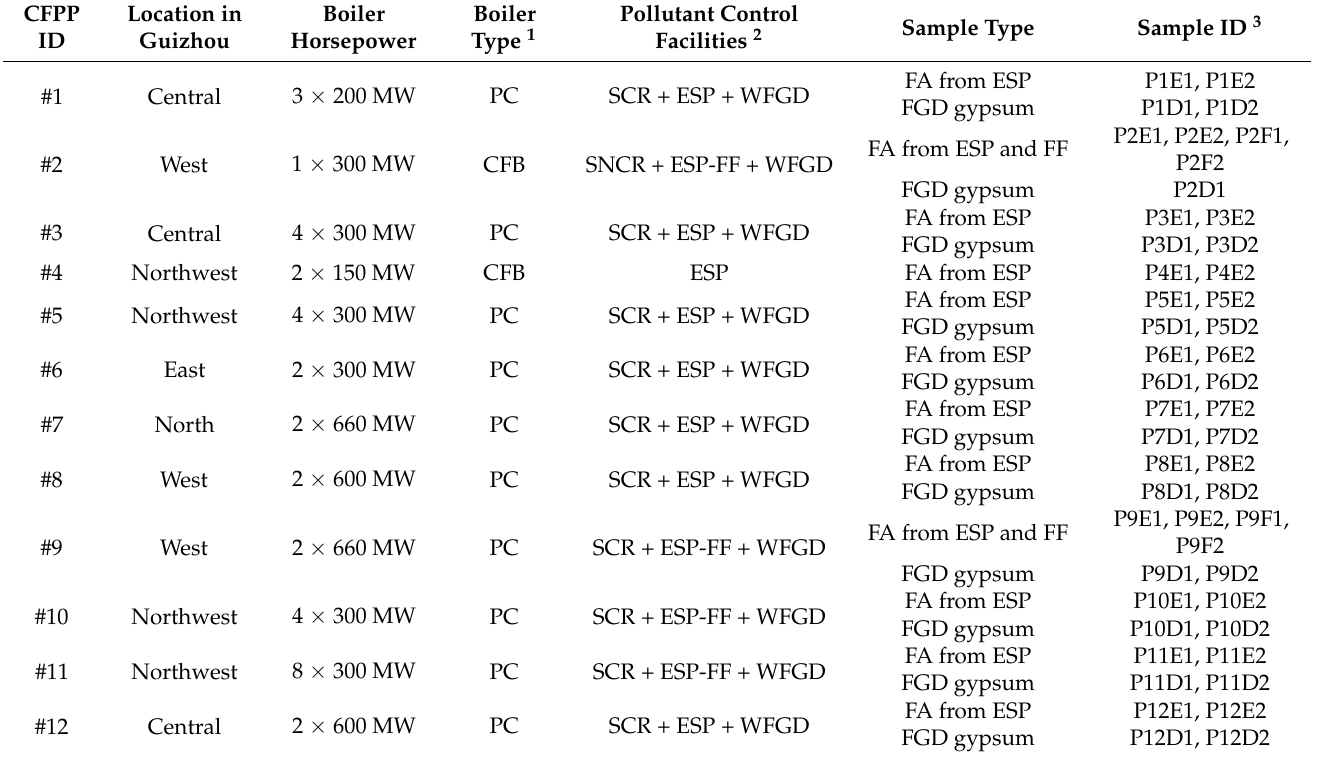
Table 1. Detailed information about the solid samples collected from CFPPs in Guizhou Province,